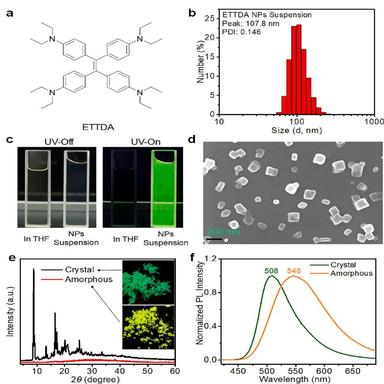
Molecular structure of ETTDA (a); size distribution diagram of the prepared NPs suspension (b); pictures of the prepared NPs suspension in comparison with THF solution of ETTDA (c); FE-SEM images of the NPs suspension (d); p-XRD pattern (e) and PL (f) spectra of crystal and amorphous powder of ETTDA, insert figures in (e) are pictures of crystal (upper) and amorphous (bottom) ETTDA powder under UV light.